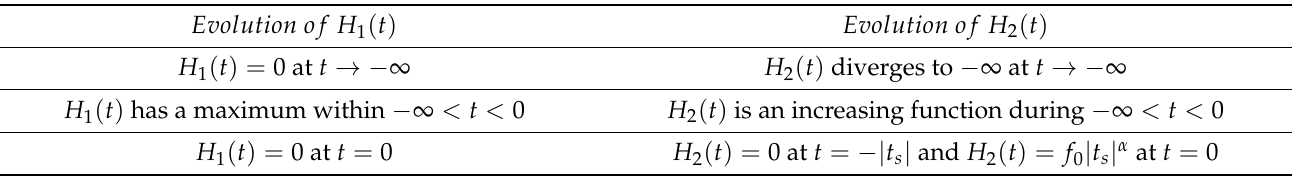
Table 1. Comparison of the evolutions of H 1 ( t ) and H 2 ( t ) at t ≤ 0. Evolution o f H 1 ( t ) Evolution o f H 2 ( t